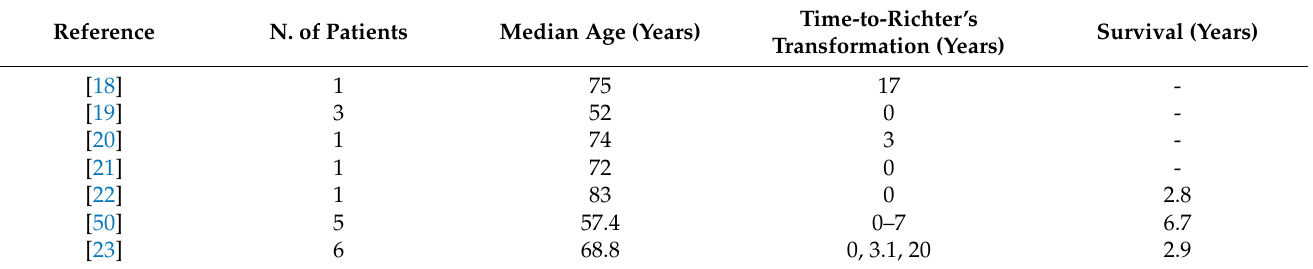
Table 2. Reported cases of HCL arising from